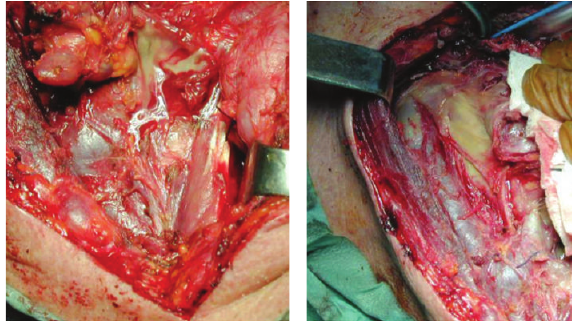
Figure 2: Patient number 1—surgical images. Yellow purulent secretions between muscular planes can be easily